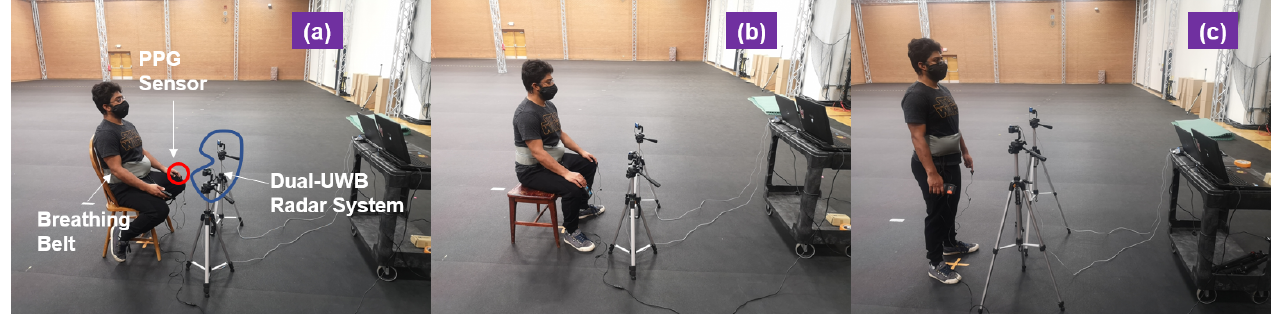
Figure 1. Novel dual-UWB radar system same-side scenario. ( a ) Stable seating; ( b ) free-style seating; ( c )